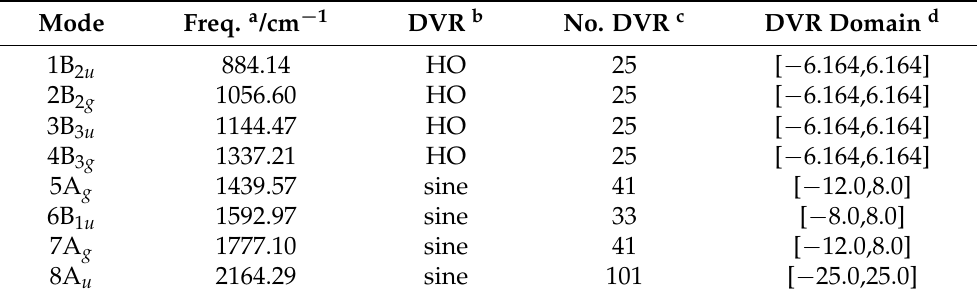
Table 4. Details of the normal modes, DVR bases and initial wavepacket conditions used in the 8D ethene calculations. ( a ) Frequencies of the normal modes calculated at the minimum energy geometry of the electronic ground state. ( b ) Type of underlying basis functions used to generate the DVR bases: sine denotes eigenfunctions of the 1D particle-in-a-box and HO refers to the eigenfunctions of the harmonic oscillator problem. ( c ) Number of DVR gridpoints for each mode. ( d ) Locations of the initial and final DVR gridpoints along each mode. Note that the sine DVR gridpoints are evenly spaced whilst the HO points are not, being more concentrated towards the